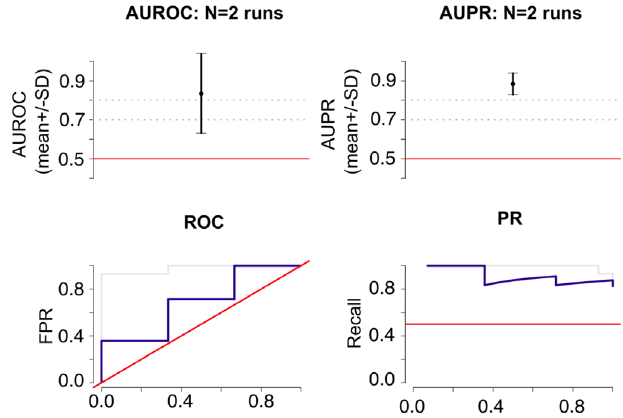
Figure 13. Performance measures for predictor that desparsifies binary somatic mutations using a user- provided gene-gene interaction